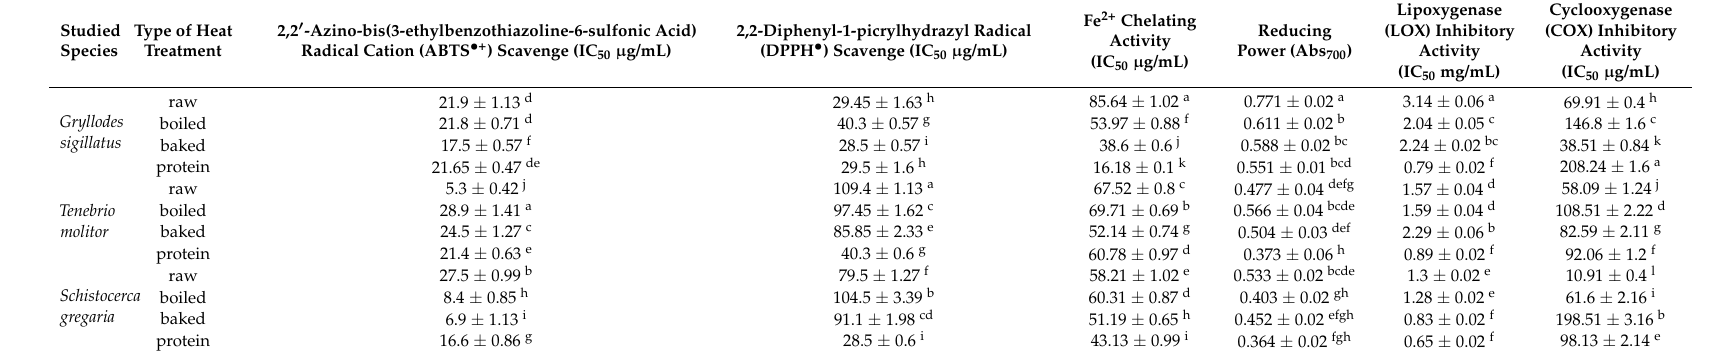
Table 1. The antioxidant and anti-inflammatory activities of hydrolysates.